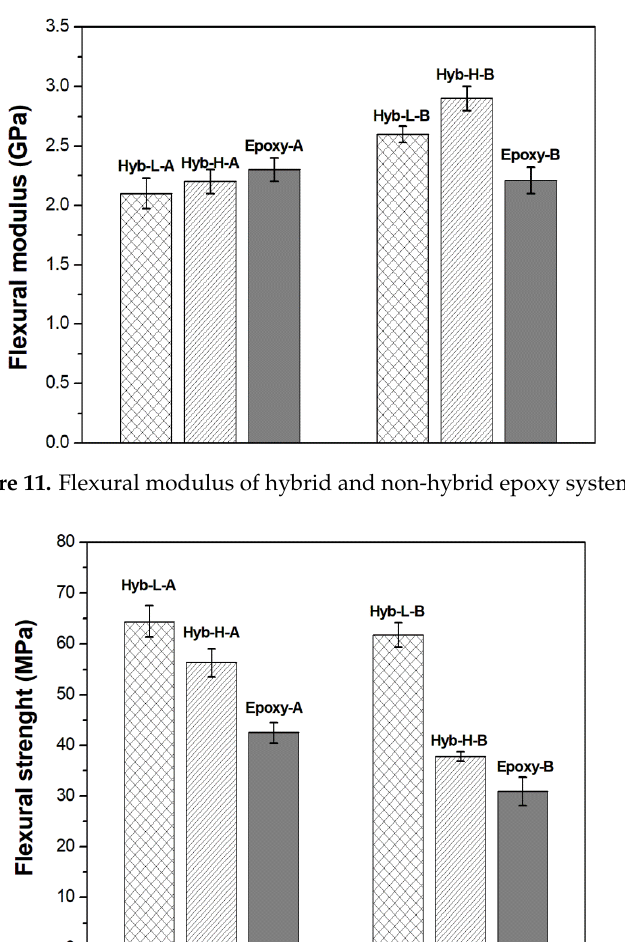
Figure 12. Flexural strength of hybrid and non-hybrid epoxy systems.